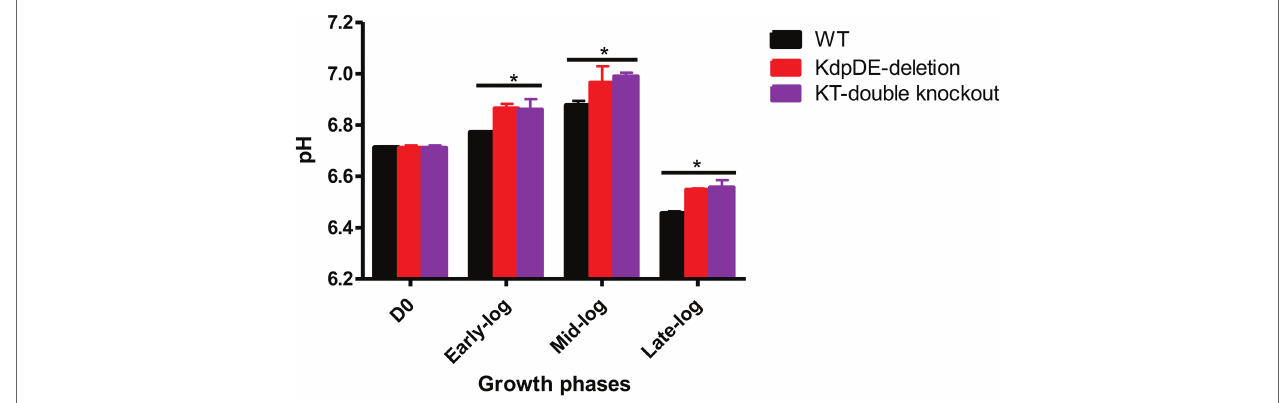
FIGURE 4 | The extracellular pH levels at the three growth phases. The results are of three experiments performed in triplicate. The pH levels were similar at D0 for all the strains 6.711 ± 0.01. The pH levels for the WT, KdpDE-deletion and KT-double knockout mutant strains at early-log were: 6.77 ± 0.011, 6.865 ± 0.017, and 6.86 ± 0.04; at mid-log: 6.876 ± 0.045, 6.965 ± 0.064, and 6.99 ± 0.04; and at late-log: 6.455 ± 0.022, 6.548 ± 0.004, and 6.557 ± 0.028, respectively. Statistically significant differences between D0 vs. the log phases are shown with an (*) representing p <